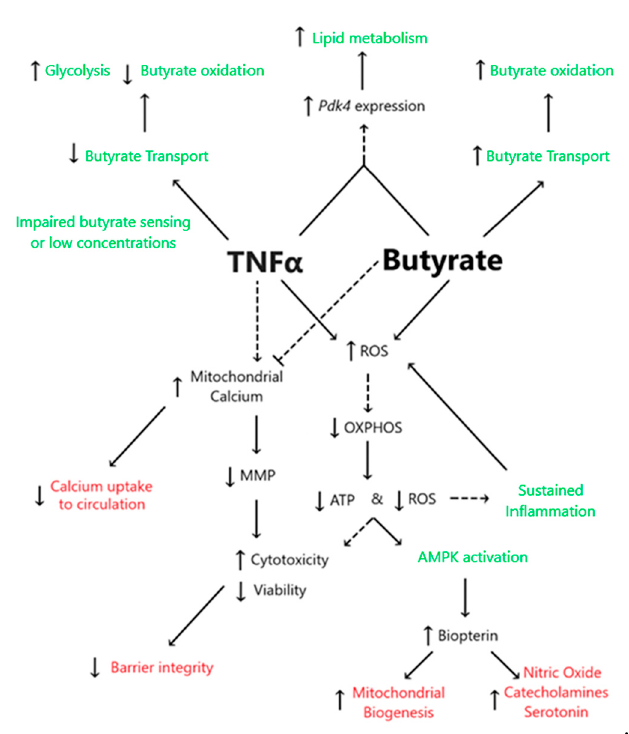
Figure 12. Proposed interactions between butyrate and TNF α in rodent CECs. Dashed lines represent predicted associations, whereas solid lines represent associations supported in the literature. Black text highlights endpoints measured within the present work, green text represents non-measured endpoints obtained from the literature, and red text represents information regarding butyrate and TNF α interactions.